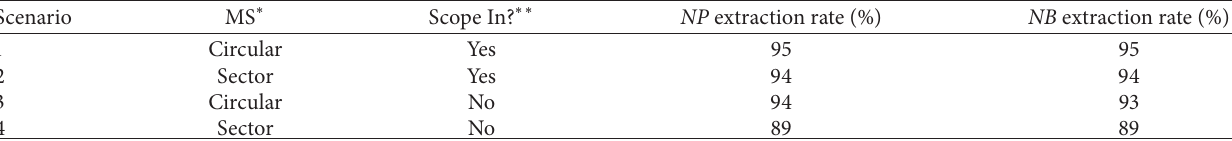
Figure 12: The extracted features. Table 2: Simulation